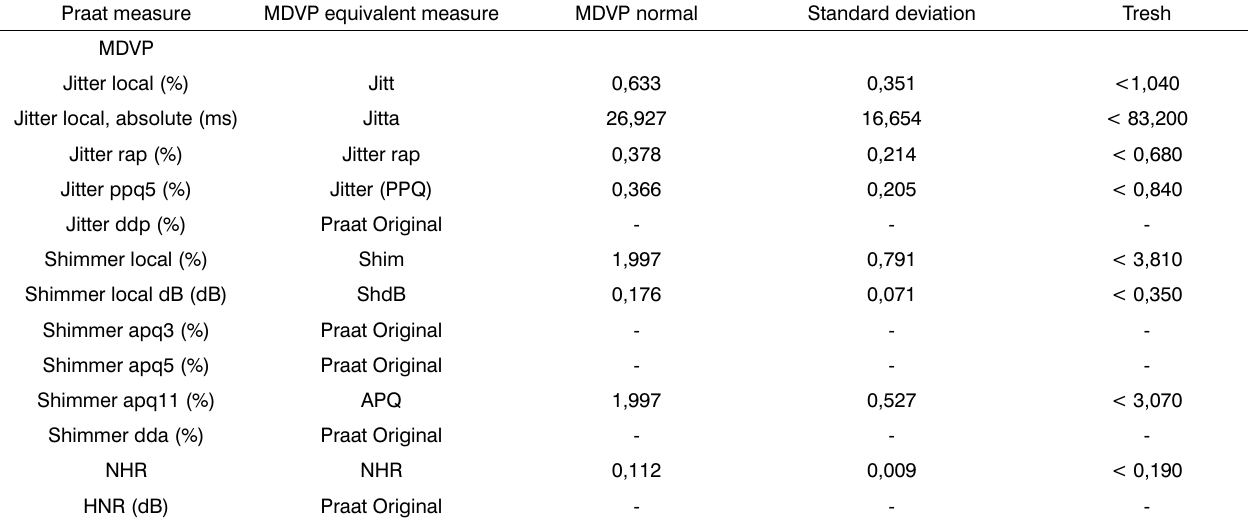
Table 2. Analogy among normal values - Praat x MDVP.